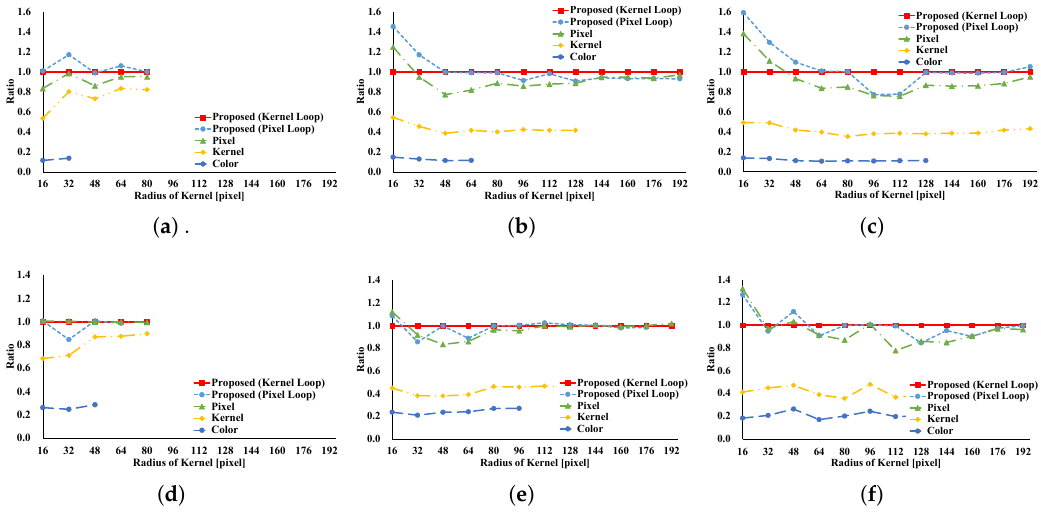
Figure 9. The speedup ratio for Gaussian range filtering (GRF) with respect to the kernel radius of FIR filtering. ( a ) Full sample in weight computation; ( b ) 1/4 subsample in weight computation; ( c ) 1/16 subsample in weight computation; ( d ) Full sample in LUT; ( e ) 1/4 subsample in LUT; ( f ) 1/16 subsample in LUT. If the ratio exceeds 1, the given pattern is faster than the kernel loop vectorization. Figures 10 and 11 indicate the results for the BF. The BF has a Gaussian spatial kernel added to the GRF’s kernel. The accessing pattern to the spatial kernel is sequential for all vectorization patterns; for this reason, the spatial kernel does not dramatically change the efficiency of all patterns in this filter. Therefore, the BF results follow almost the same trend as the GRF